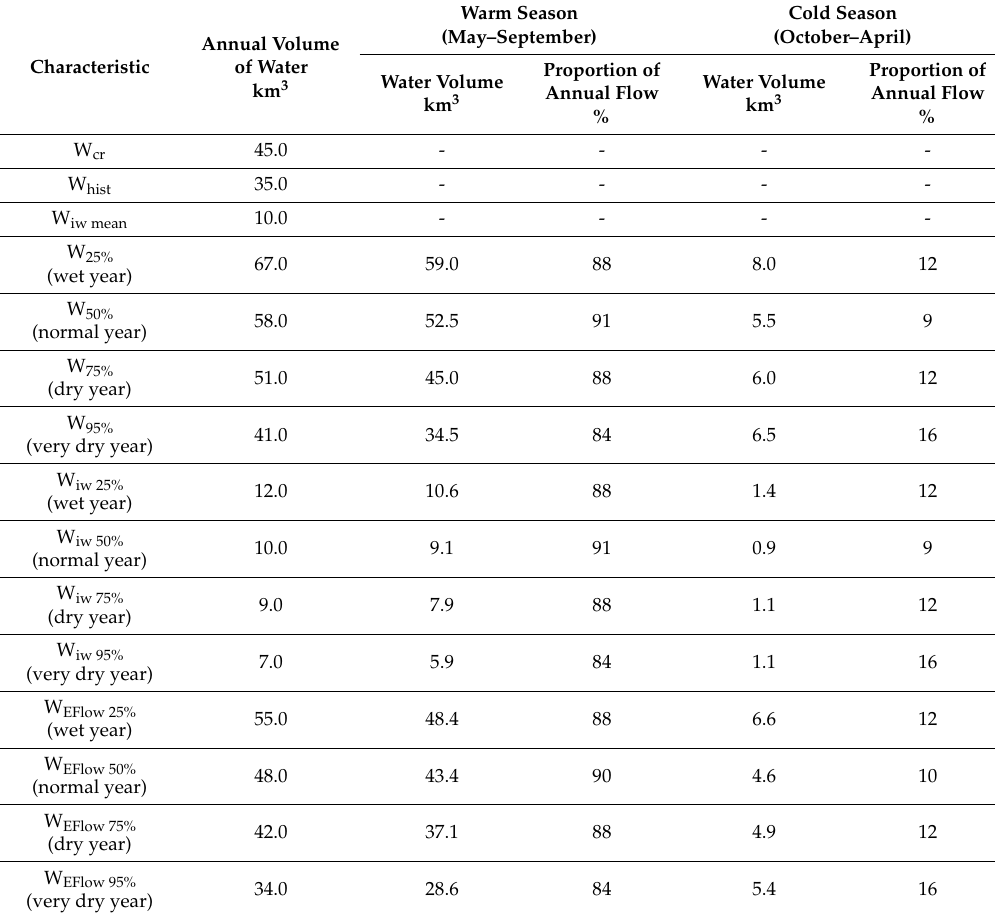
Table 1. Annual and intra-annual distribution of surface water withdrawal and environmental flow volumes of the Zeya River basin for di ff erent water